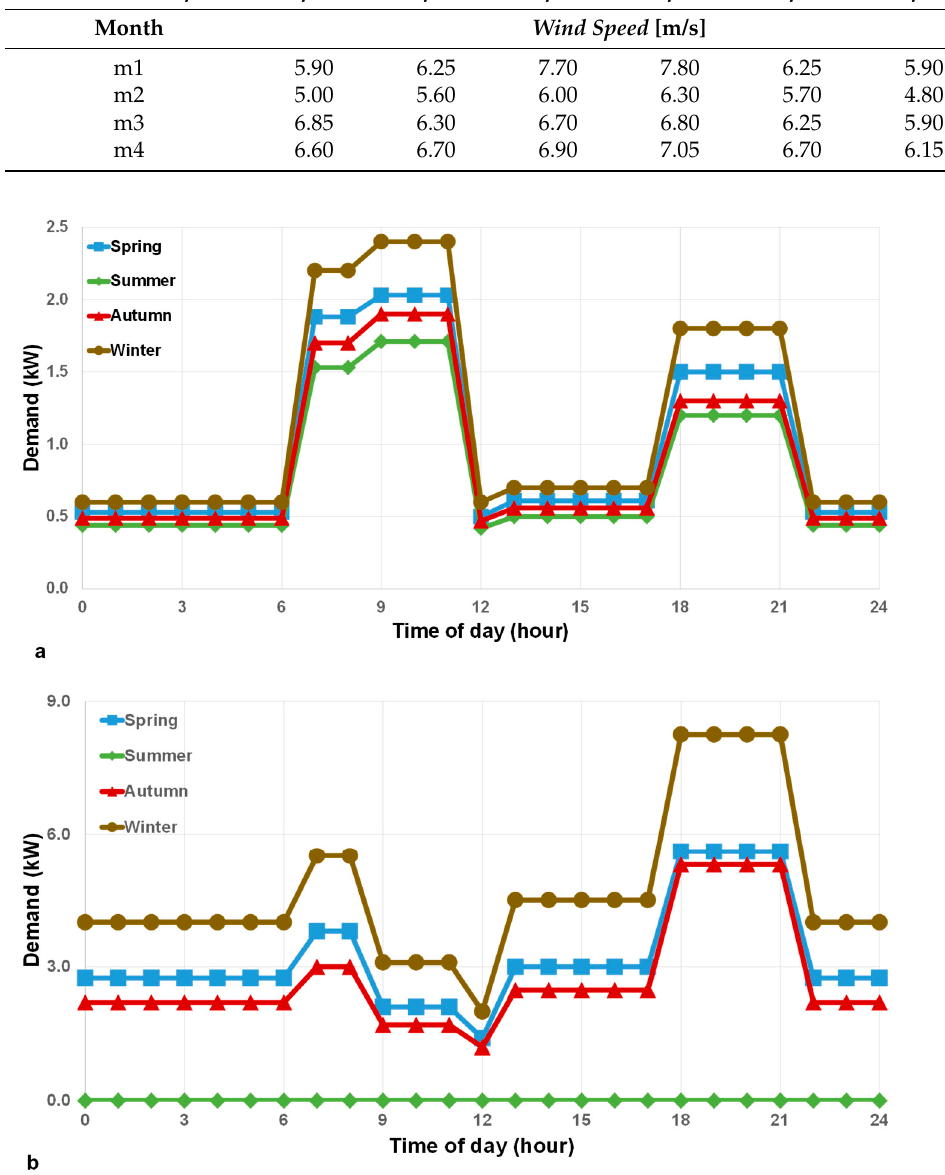
Table 3. UK wind speed data (adapted from [16]).